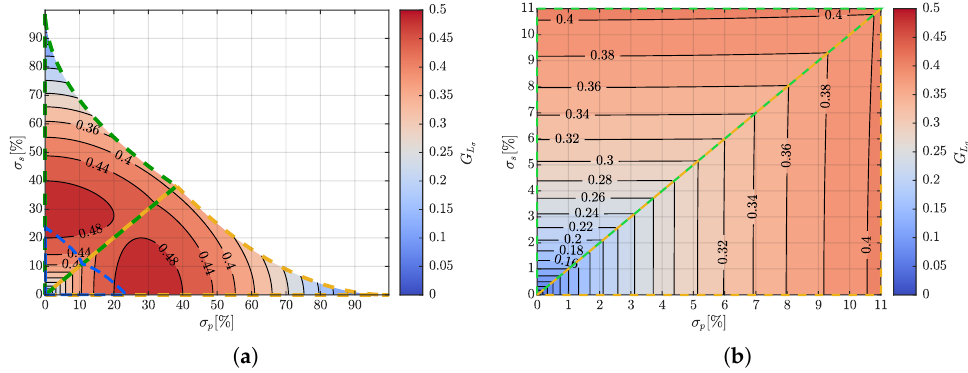
Figure 6. Visualization of G L given in (24). The triangle with green dashed lines corresponds to the σ set I given in (25a), and the one with orange dashed lines corresponds to the set J given in (25b). ( a ) For σ p ≤ 100% and σ s ≤ 100%. ( b ) For σ p ≤ 11% and σ s ≤